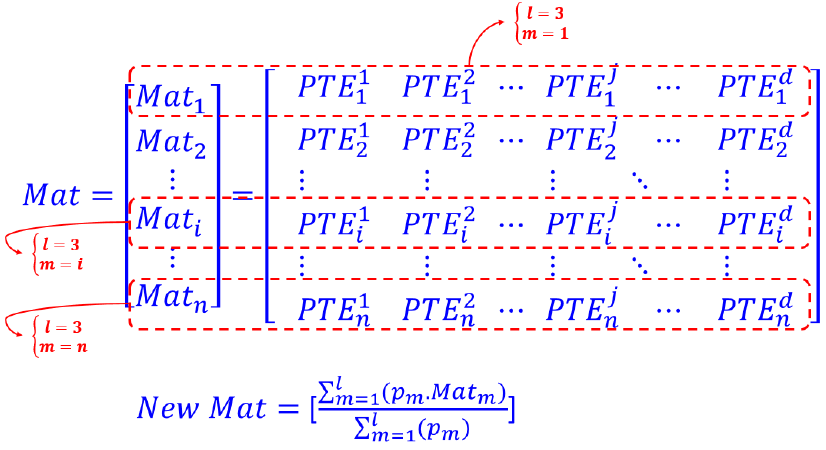
Figure 5. The schematic view of the random material selection for creating new materials.